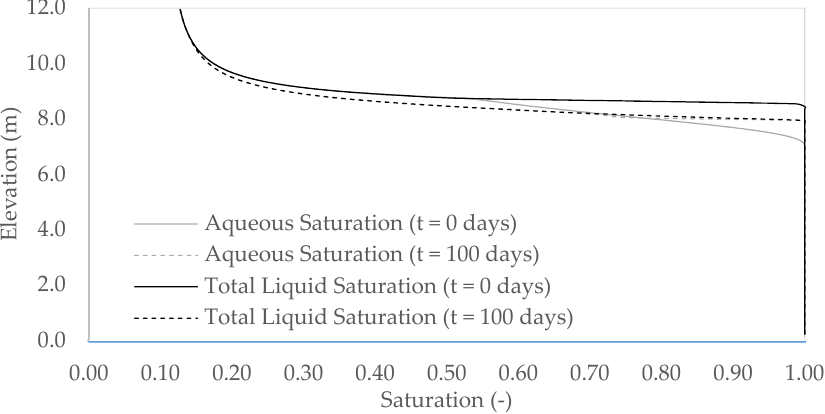
Figure 9. Aqueous and total saturation variation (initial and final) in TE6 under 24.93 kPa for silty sand.